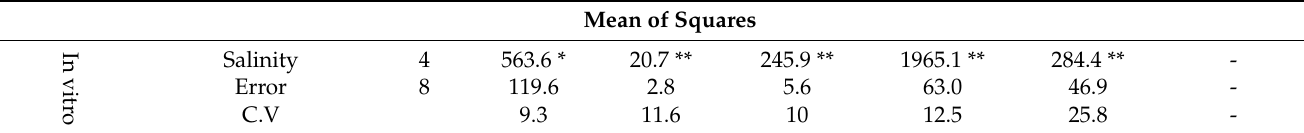
Table 3. Cont. Mean of